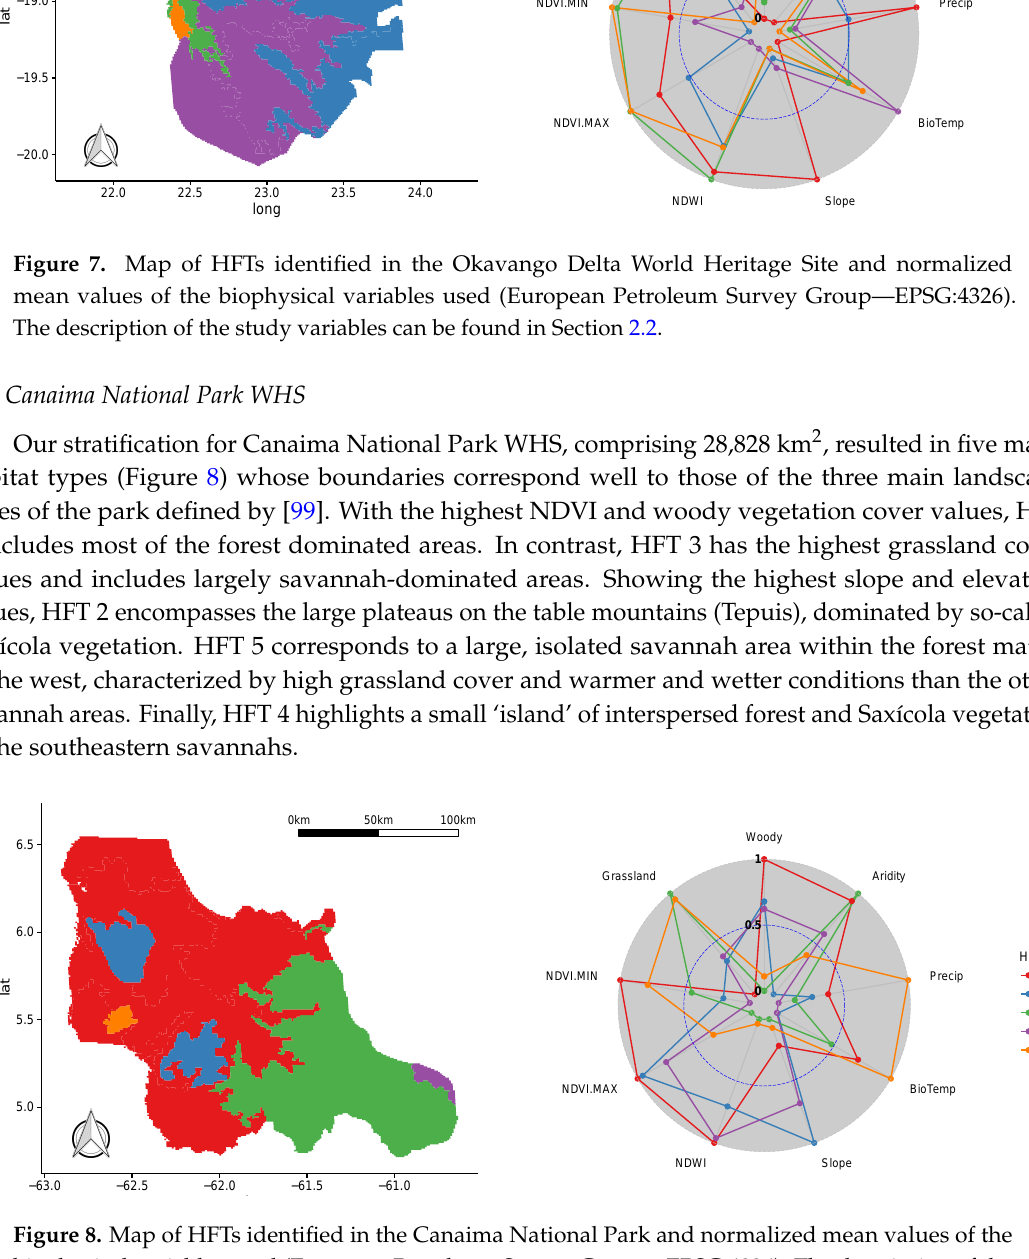
Figure 8. Map of HFTs identified in the Canaima National Park and normalized mean values of the biophysical variables used (European Petroleum Survey Group—EPSG:4326). The description of the study variables can be found in Section